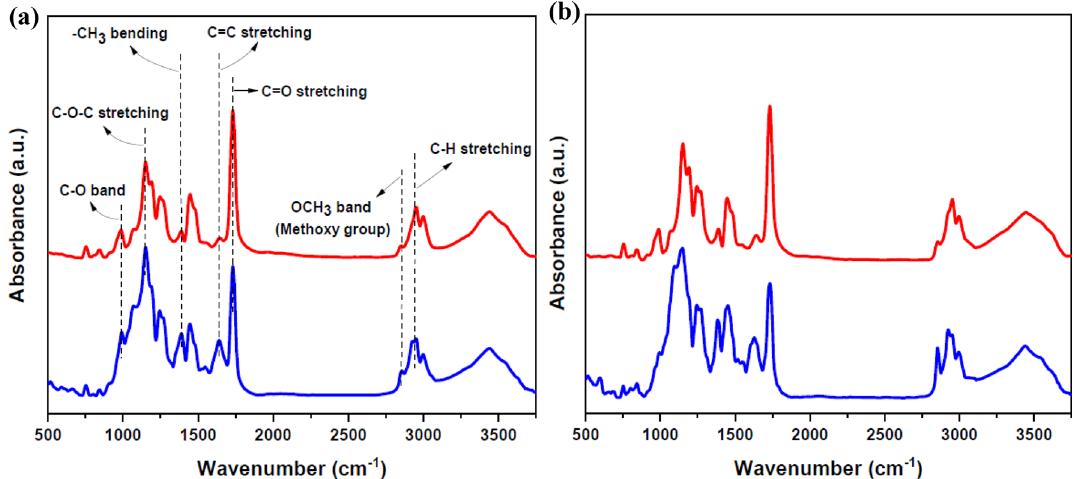
Figure 1. FT-IR spectra of ( a ) pure PMMA polymer layer ( b ) DR1 dye-doped PMMA polymer layer and (blue lines) untreated samples (red lines) argon plasma-treated samples for 300 s